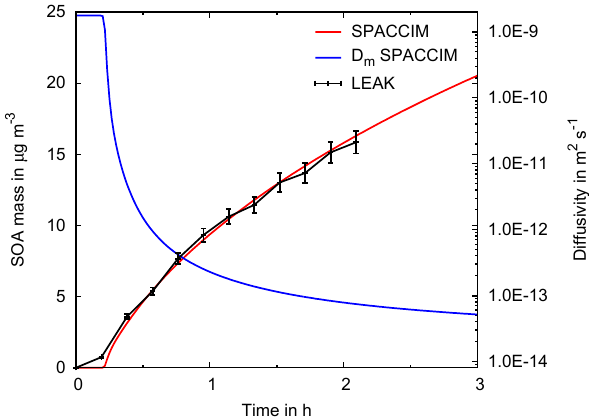
Figure 9. Simulated SOA mass as shown in Fig. 8 for k c = 10 − 2 s − 1 , k b = 10 − 2 s − 1 , under consideration of HOMs, and with the weighted diffusion coefficient utilizing D org = 10 − 14 m 2 s − 1 in comparison to the measured SOA mass from the LEAK experiment. The corresponding weighted particle-phase bulk diffusion coeffi- cient D m from the simulation is displayed on the secondary y